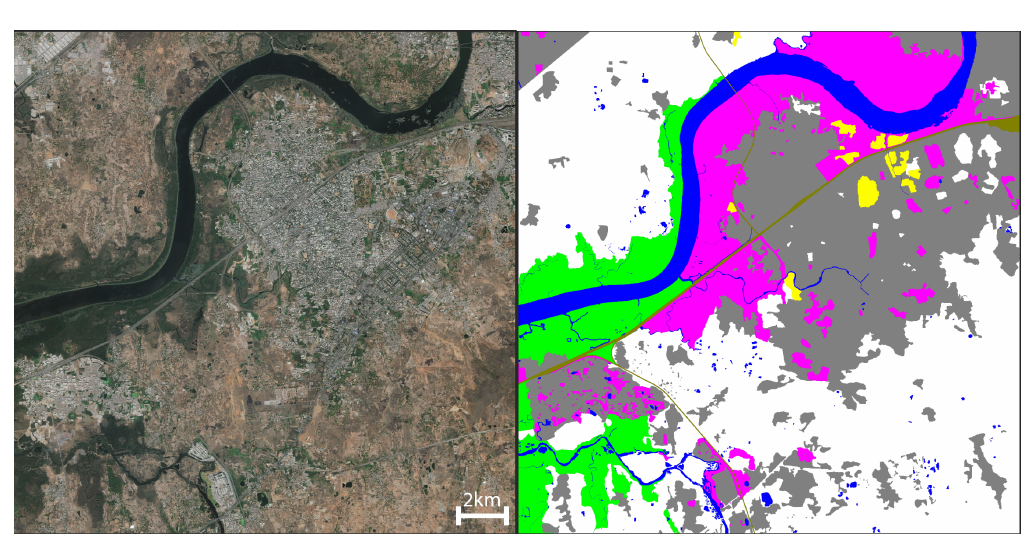
Figure 15. Land Cover Classification. We explore automatic detection of city-like areas from satellite images for areas that do not publicly have city boundary